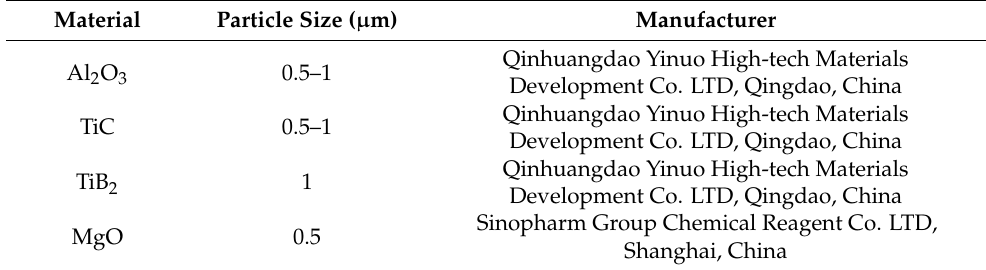
Table 1. The raw material.